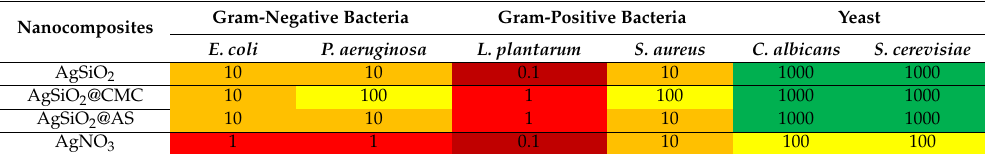
Table 5. Minimum biocidal concentration (MBC) for Ag / SiO 2 and its derivatives after a 24 h exposure in deionized water at 297 K on the bacterial and yeast strains in nominal concentrations from 0.01 up to 1000 mg / L. The results were combined with the reference Ag + -ions (AgNO 3 ). Di ff erent colors indicate di ff erent MBC values. All of the values were obtained based on experiments in three